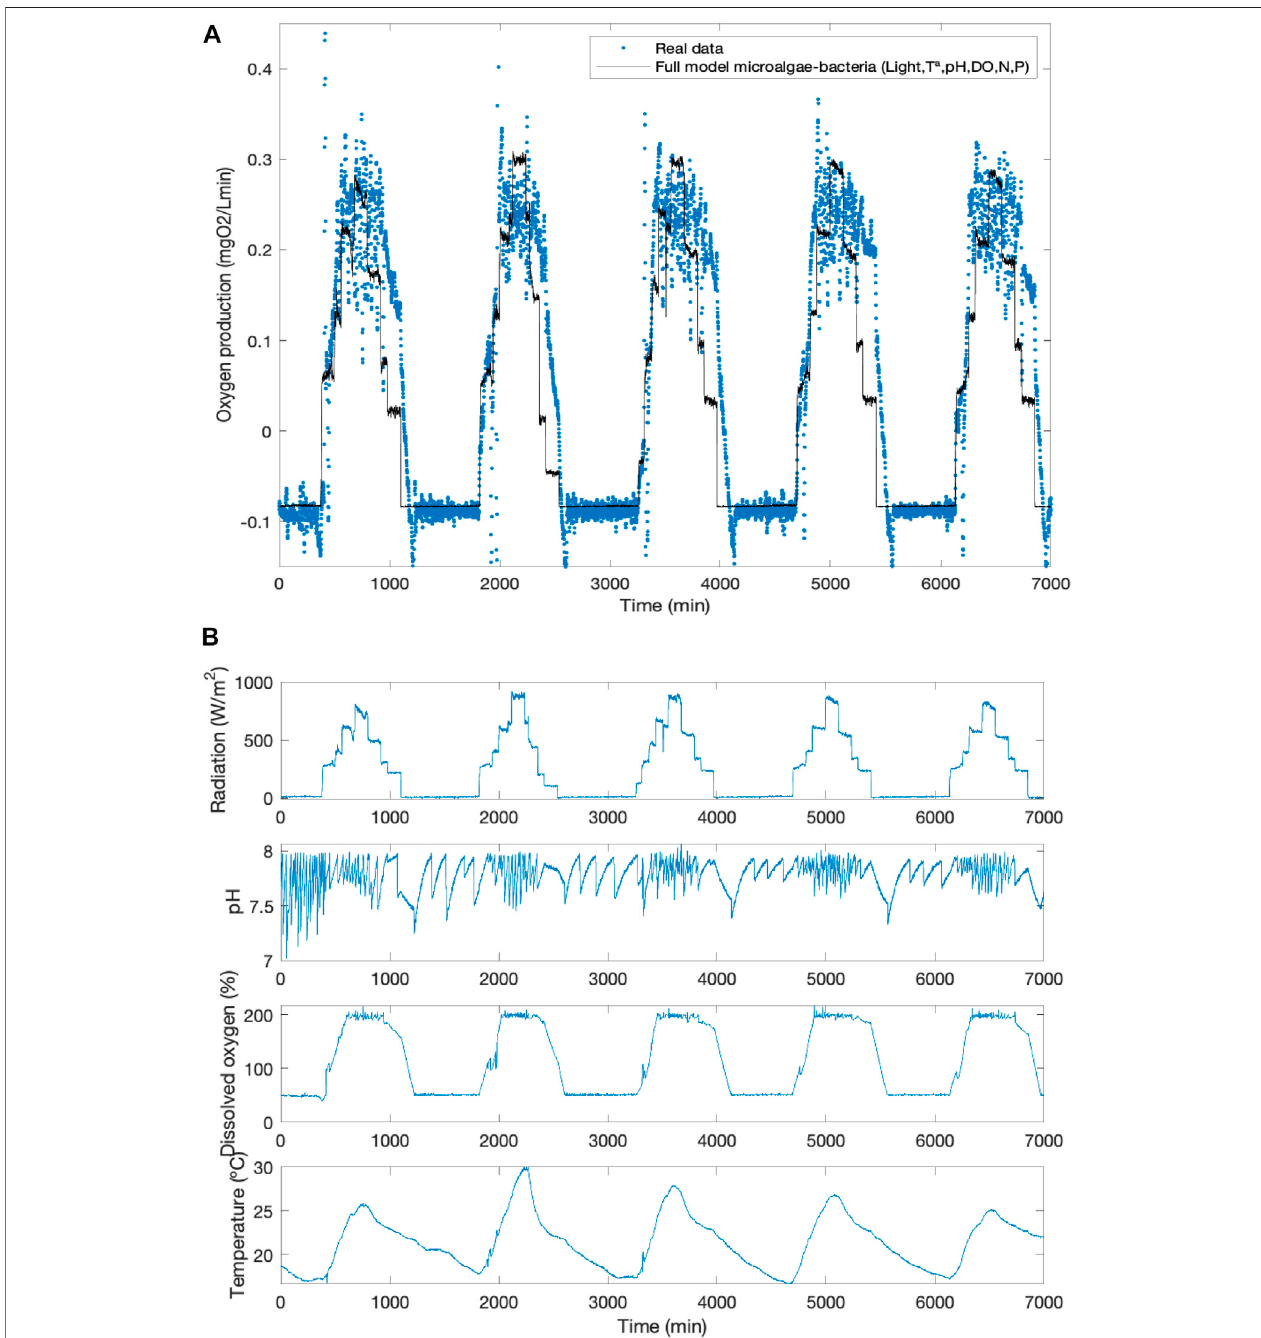
FIGURE 3 | Experimental validation of the full microalgae-bacteria model proposed (A) , Real input data from the laboratory stirred-tank reactor used for the validation (B) .